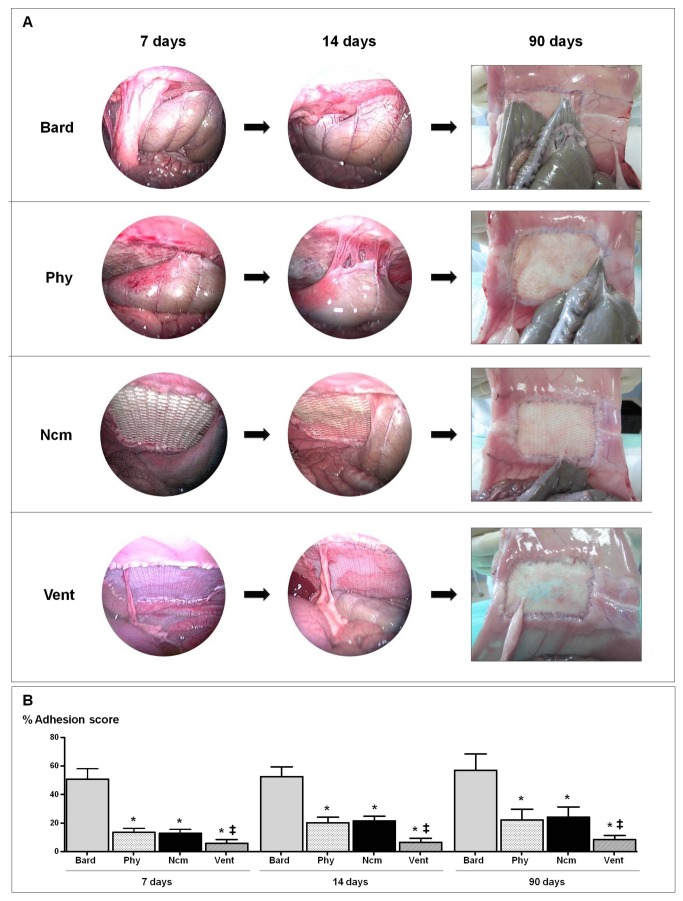
Laparoscopy study.A) Sequential laparoscopy tracking of adhesions 7, 14 and 90 days after implant in the groups: Bard meshTM, PhysiomeshTM, the composite mesh and VentralightTM. B) Percentage prosthetic areas covered by tissue adhesions recorded for each group. PhysiomeshTM (Phy), new composite mesh (NCM), VentralightTM (VL). (*p<0.05 versus Bard; ‡p<0.05 versus Phy and NCM).